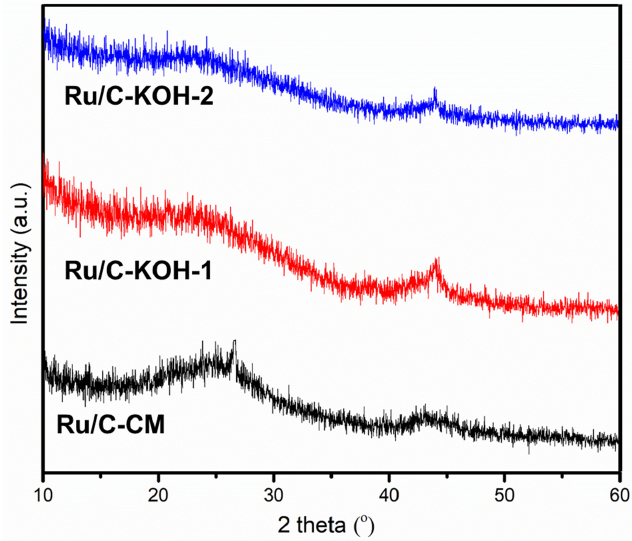
Figure 1. XRD pattern of investigated Ru/C catalysts.